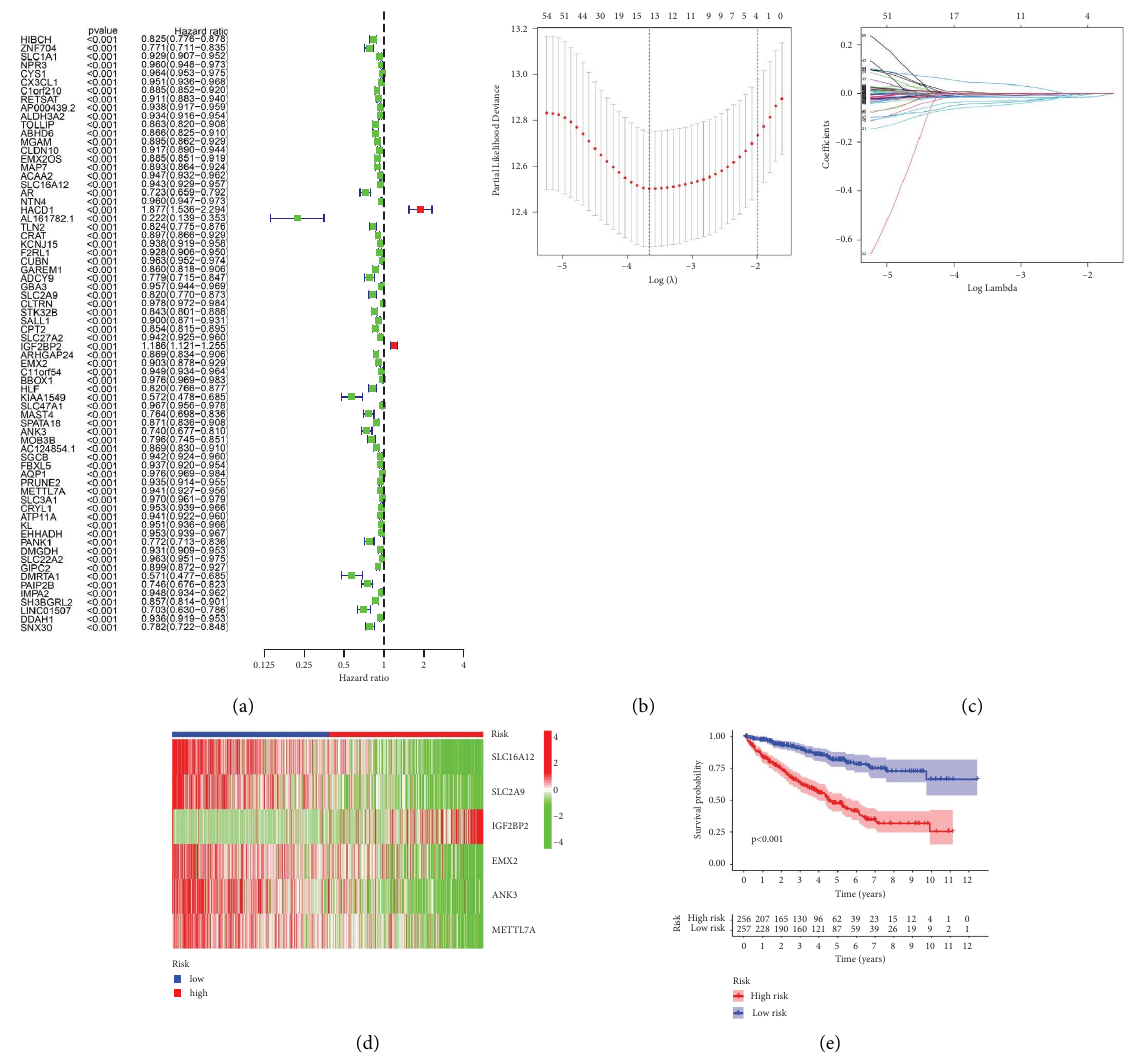
Figure 2: (a) Te univariate COX regression analysis based on the overall survival (OS) and the expression of MEred genes; (b, c) the LASSO regression analysis demonstrated that 12 genes are closely associated with the prognosis of RCC patients; (d) the heatmap demonstrated the diferent expression level of 6 prognosis-related genes between the low- and high-risk groups; (e) the survival analysis between the low- and high-risk